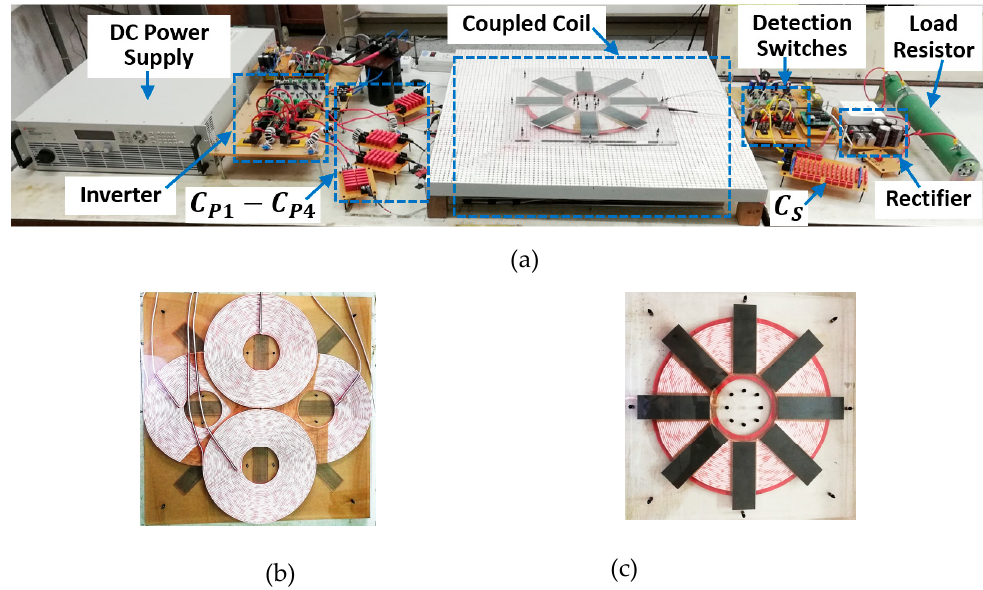
Table 2. Measured circuit parameters.